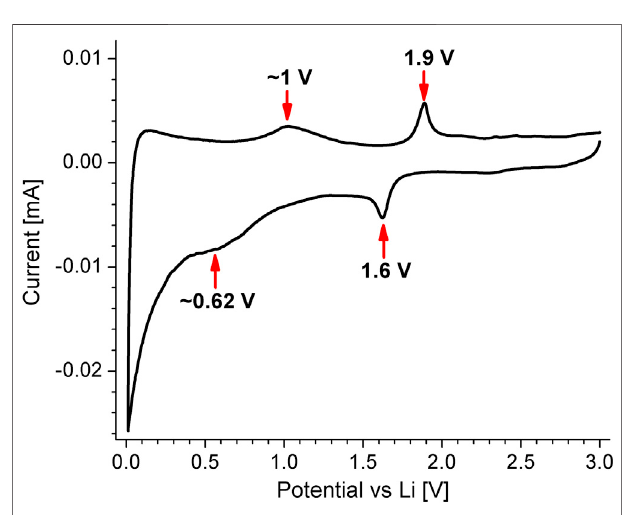
FIGURE 5 | Cyclic voltammogram of a half battery cell with Mx-Onyx as working electrode.